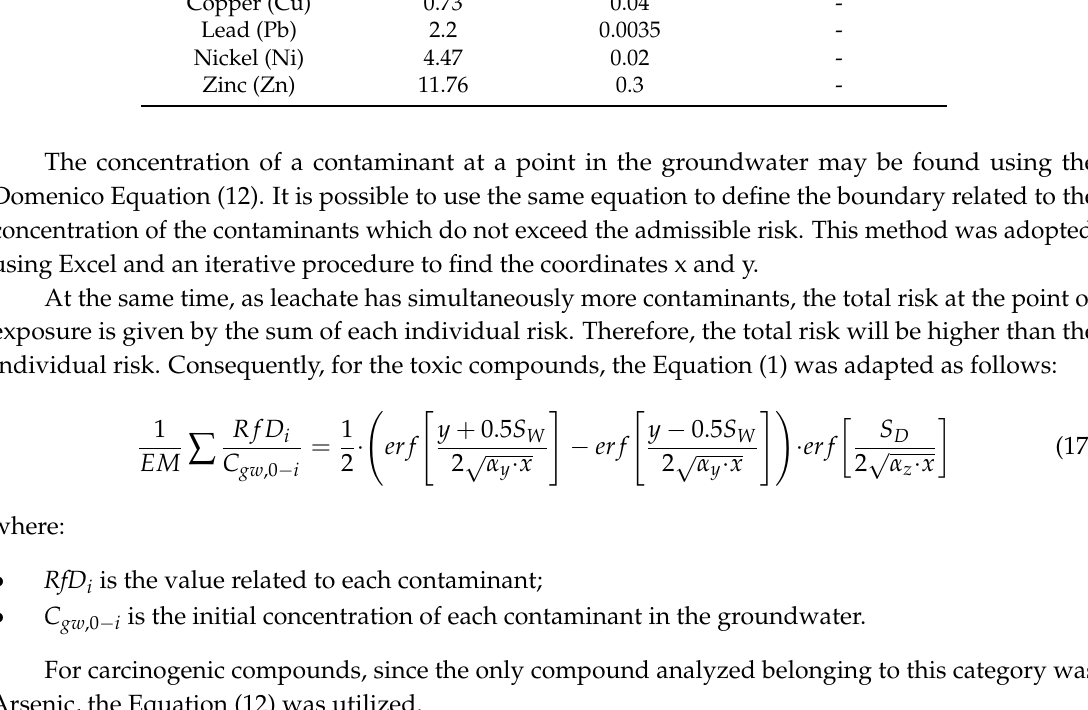
Distance between water table and soil level (L GW )